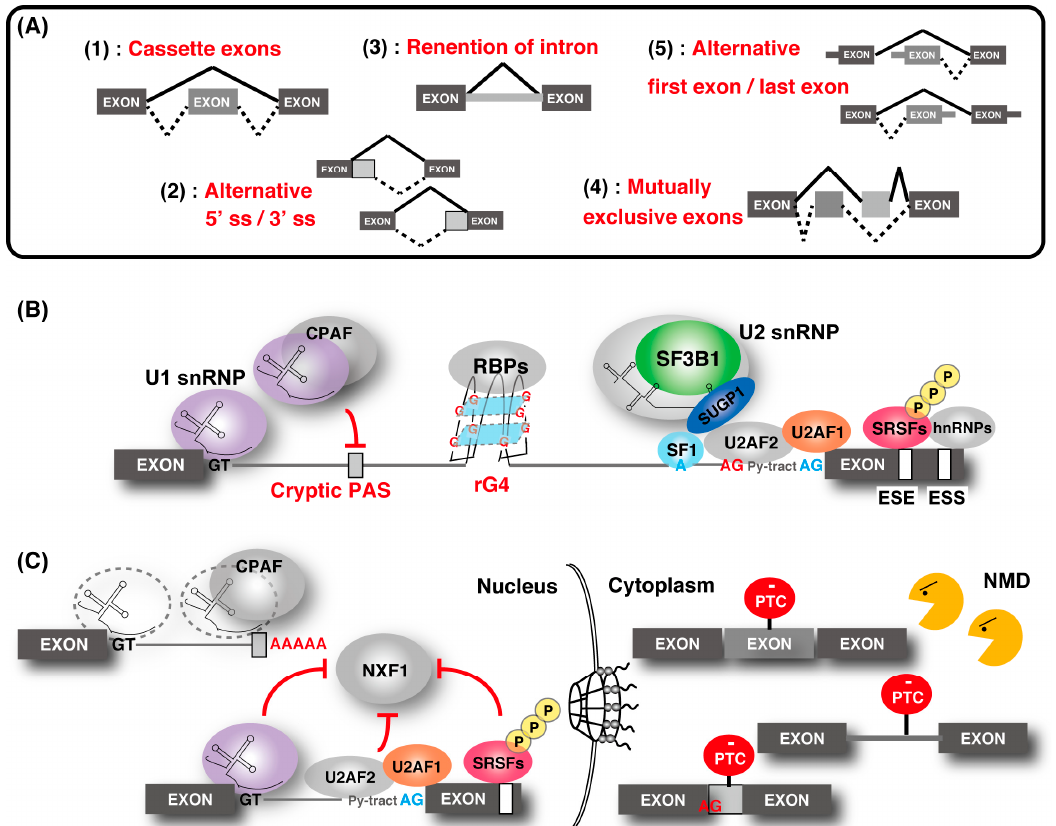
Figure 1. Regulation of gene expression through alternative splicing. ( A ) Five types of alternative splicing events. "Cassette exons" means inclusion or skipping of an exon. ( B ) Outline of the alternative splicing control by various factors. The U1 ribonucleoprotein (snRNP) function to recognize the 5 (cid:48) splice site (ss) and the cryptic polyadenylation signals (PASs) with cleavage and polyadenylation factors (CPAFs). Splicing factor 1 (SF1), U2 snRNP auxiliary factor 1 (U2AF1), and U2AF2 bind the branch point (BP; shown as a blue “A”), polypyrimidine tract (shown as “Py-tract”), and 3 (cid:48) ss (shown as a blue “AG”), respectively. U2 snRNP containing splicing factor 3B1 (SF3B1), SURP and G-patch domain containing 1 (SUGP1) displaces SF1 and binds to the BP. SR protein families and hnRNPs recognize the exonic-splicing enhancer (ESE) and exonic-splicing silencer(ESS) elements, respectively, and contribute to the recognition of the splice site and the spliceosome assembly by splicing factors. The cryptic 3 (cid:48) ss (shown as a red “AG”) recognition is repressed by hnRNP. RNA G-quadruplex (rG4) structures a ff ect splicing by acting as RNA-binding protein motifs. ( C ) Association of alternative splicing and gene regulation. Without U1 snRNP, the CPAF recognizes intronic PASs and generates short transcripts due to premature cleavage and polyadenylation. Some intron-containing transcripts are associated with U1 snRNP, U2AF2, and SR proteins, and they are tethered in the nucleus. Intron-containing transcripts, which are exported to the cytoplasm, often contain a premature termination codon (PTC) and are eliminated by nonsense-mediated messenger RNA (mRNA) decay (NMD). Similarly, other alternative and cryptic-spliced transcripts with PTC are also degraded by